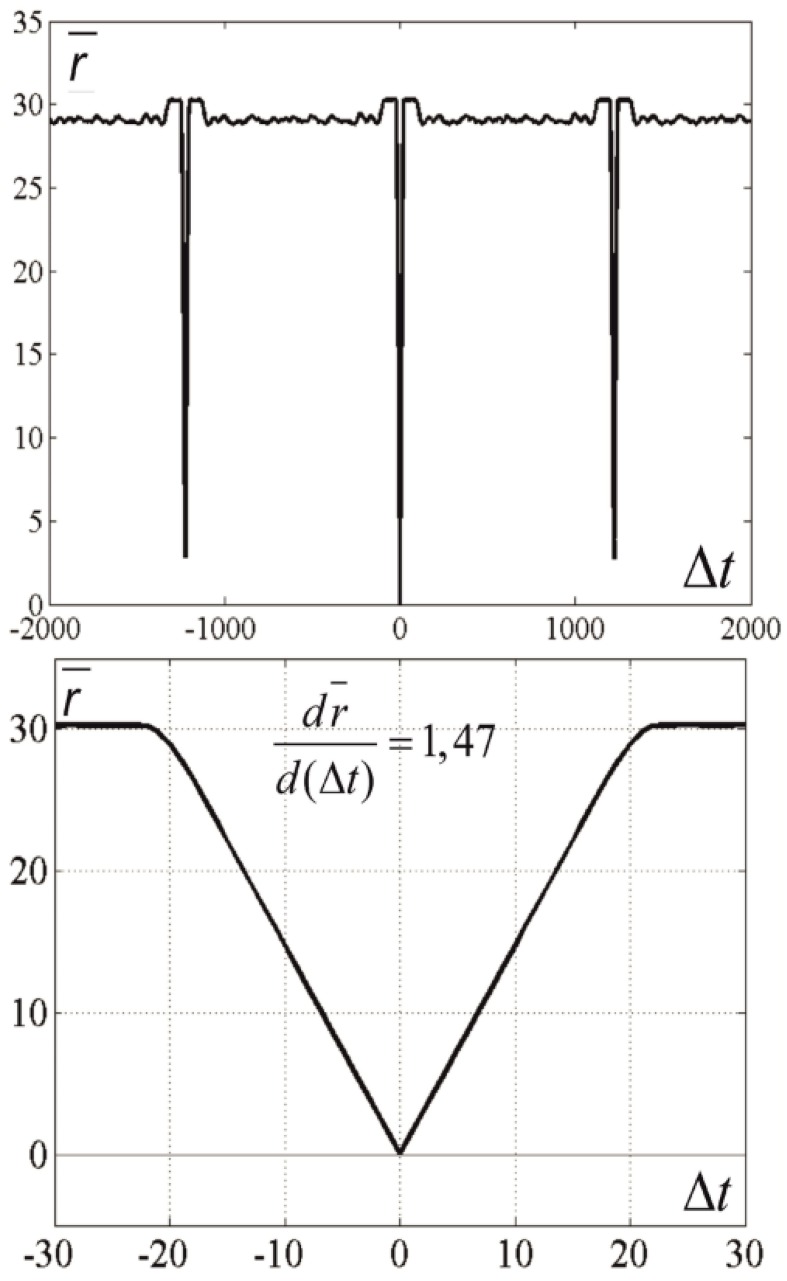
Average distance between the current state and past and future states. Top and bottom differ in time scale. N = 300, M = 900, Tnet = 1225. The Figure is obtained by averaging the data, plotted at Figure 4 over the horizontal axis. Ordinate—distance between the states of neural network V(t) and V(t + Δt), averaged over t-values of Figure 4. It is first obvious that the “periodicity” of activity in the network is noisy: the distance minimums at T = ±1225 are not zeros. It is also obvious that the dependence of distance on time difference is linear, when distance is close to zero. This fact makes well-defined the velocity of propagation at |Δt| < 15. This fact enables “counting the number of states,” which activity of the network attends over the cycle of periodic activity, in this case M' = 900.37 ≈ 900 = M.